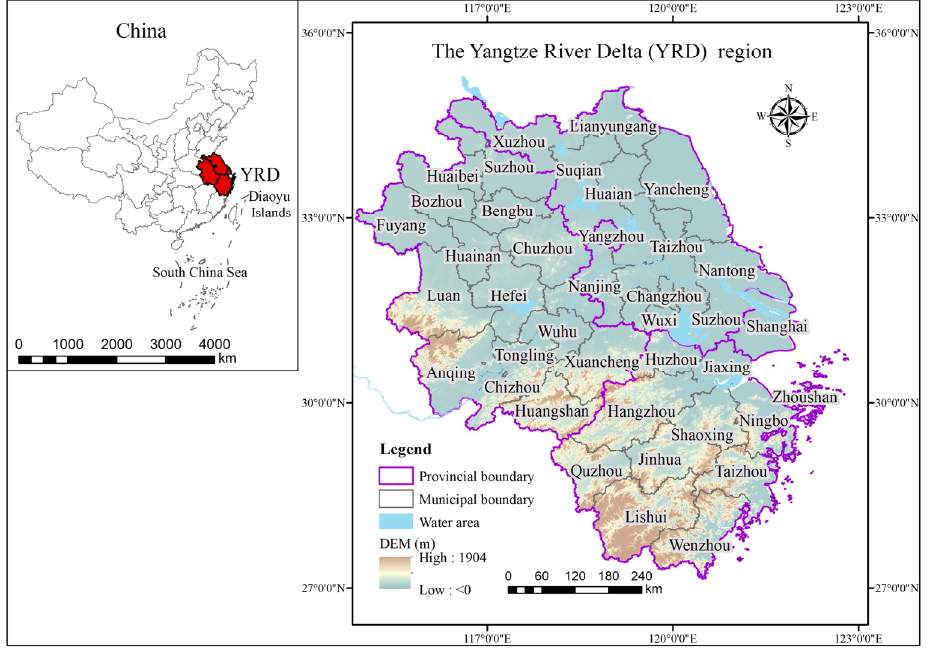
Figure 2. The Yangtze River Delta and administrative divisions.